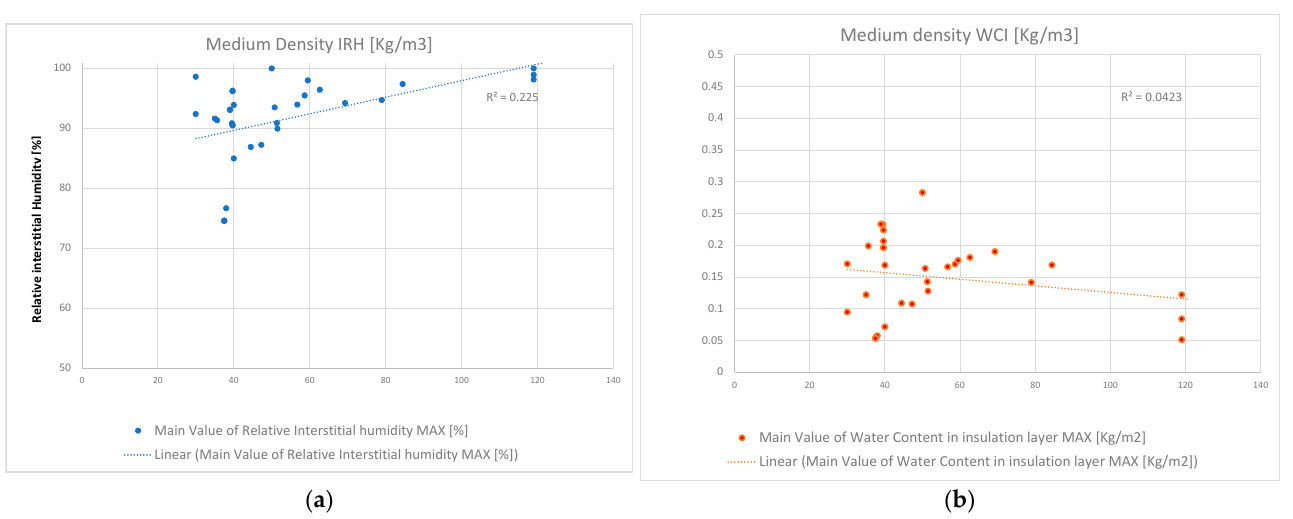
Figure 6. ( a ) Results of the insulation density mean values as a function of the amount of IRH. ( b ) Results of the insulation density mean values as a function of the amount of WCI. The dispersion graphs in Figure 7 represent: (a) the trend of the vapour permeability coefficient of the insulation (-) as a function of the amount of IRH (%) and (b) the trend of the vapour permeability coefficient of the insulation with respect to WCI (kg/m 2 ). The average has been calculated with respect to the reference period in which the maximum IRH value occurs in the 10 years of simulation. The dispersion graphs in Figure 8 represent: (a) the trend of the values relative to the conductivity of the materials in function of the quantity of IRH, where, in abscissae, the values relative to the conductivity (W/mK) are reported, while in ordinate, the values in percentage of the quantity of humidity are shown, and (b) the same trend, however, in ordinate, the quantity of water inside the insulation is